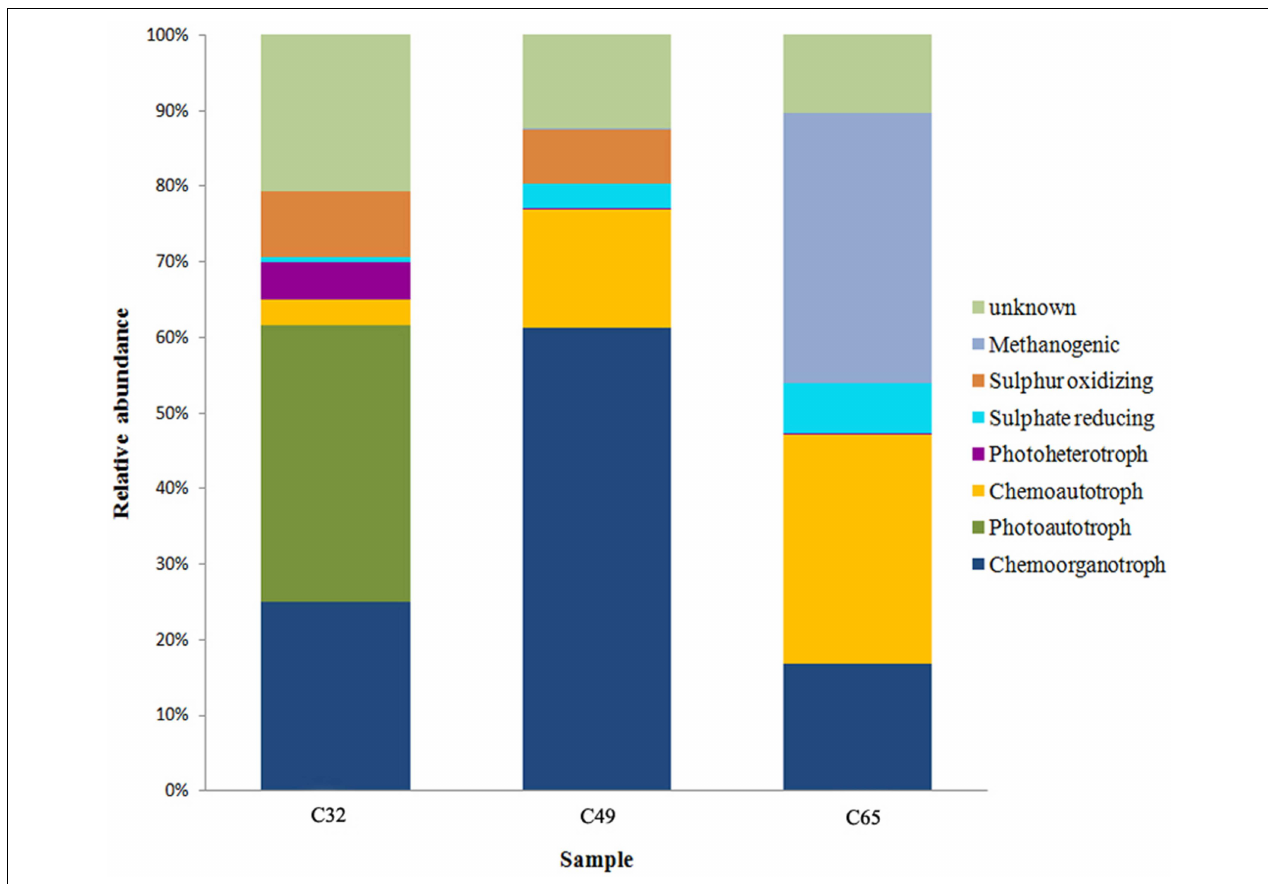
FIGURE 7 | Relative abundance distribution of putative bacterial functional groups in the carbonate deposits from Ciocaia. The histograms are constructed based on the taxonomic affiliations inferred from the 16S rRNA genes.